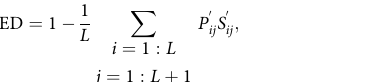
0.8 00.20.40.6 0.41 0.36 0.41